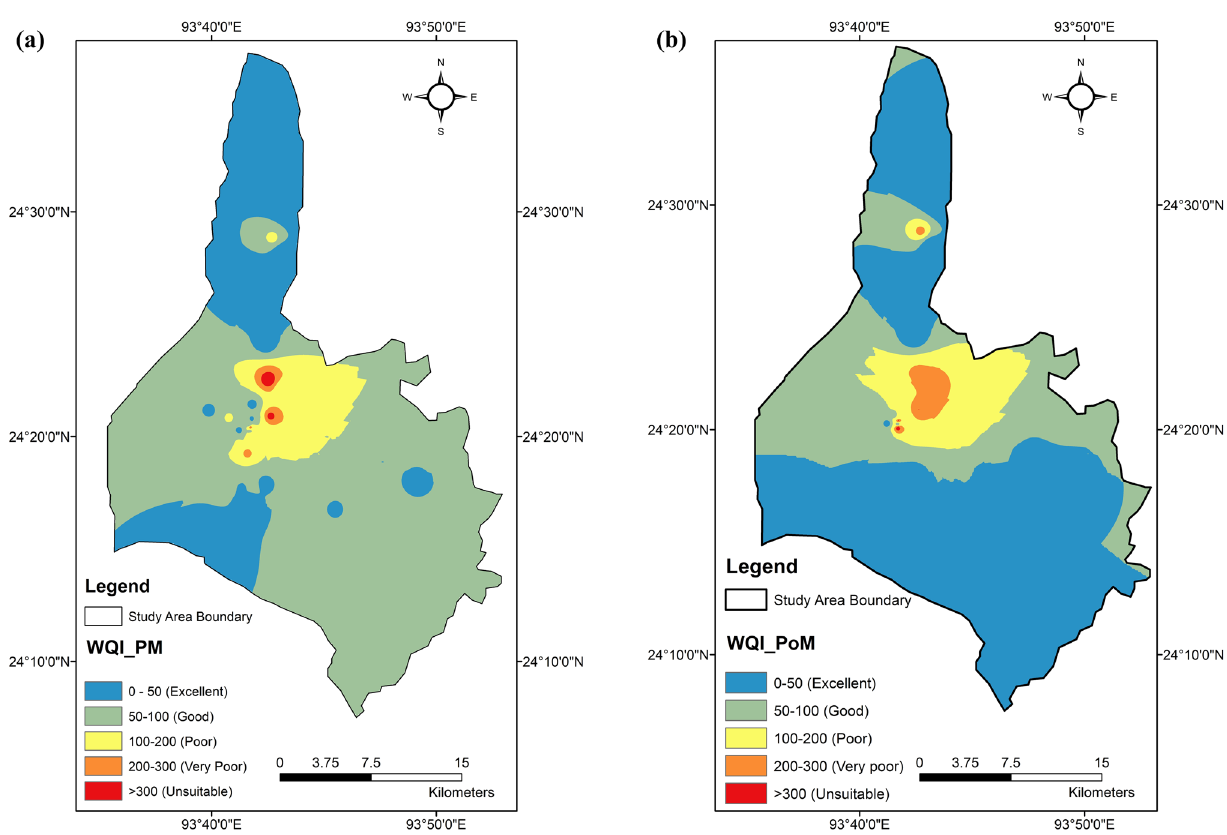
Fig. 3 The map showing the spatial distribution of WQI in the study area during a PM and b PoM seasons